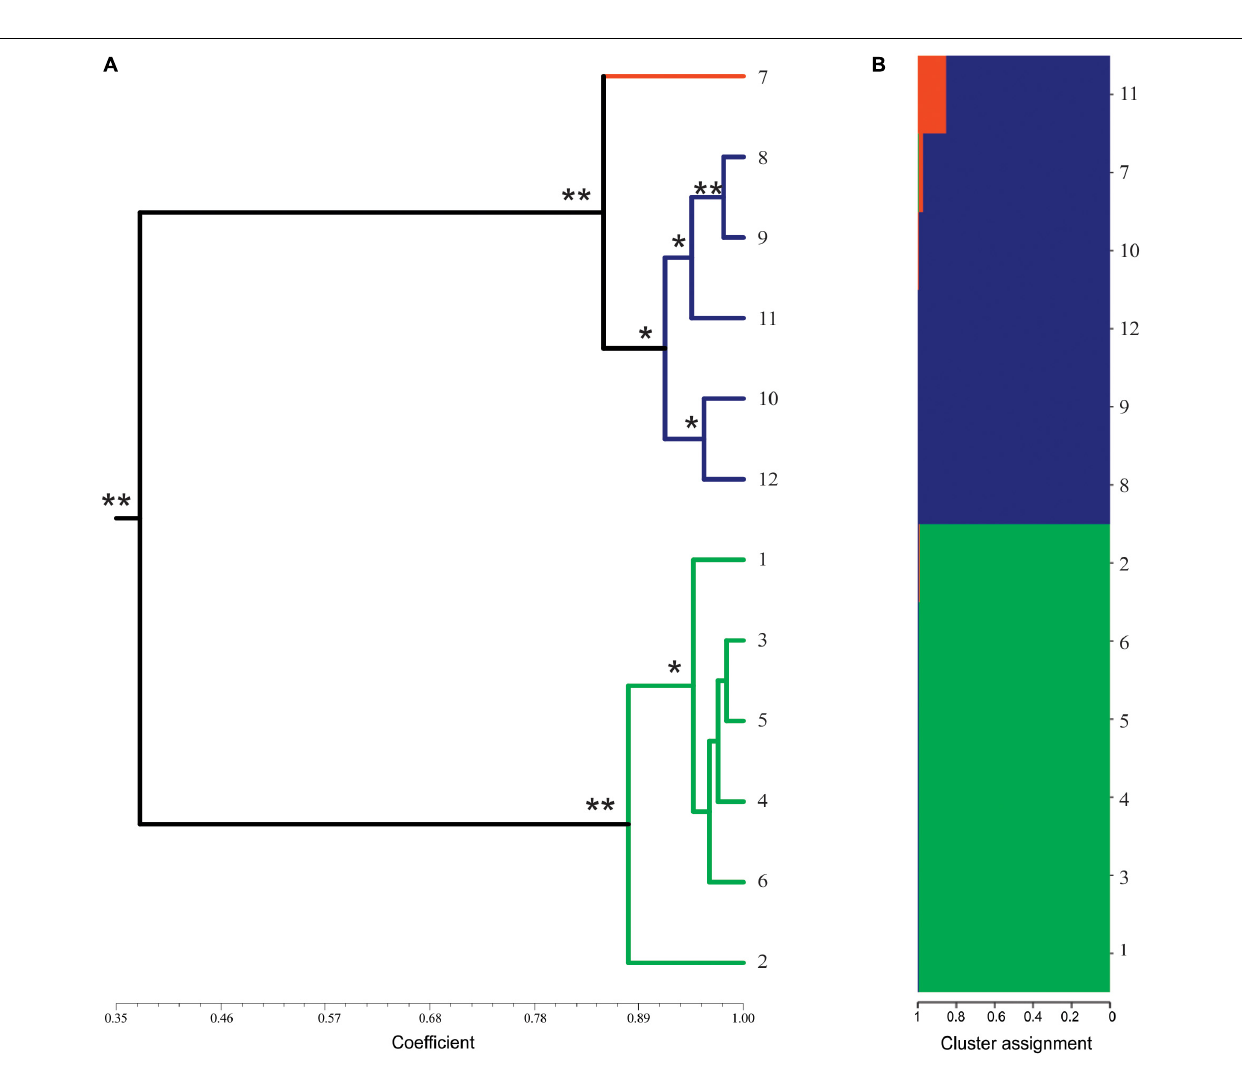
FIGURE 3 | Molecular profile of synthetics plants of Lippia alba . (A) Dendrogram of genetic similarity by UPGMA of presence/absence of alleles using combined data (ISSR and SSR makers) from 12 plants of L. alba . The colors of the branches represent different ploidal levels: diploid in orange, triploid in green, tetraploid in blue. * represents bootstrap values above 50% and ** represents bootstrap values above 90%. Dendrograms with JACCARD and DICE coefficients were identical. (B) Bayesian analysis of the genetic structure of 12 plants of L. alba . The colors represent the proportion of the genome shared for each individual. Similar genomes are represented by the same